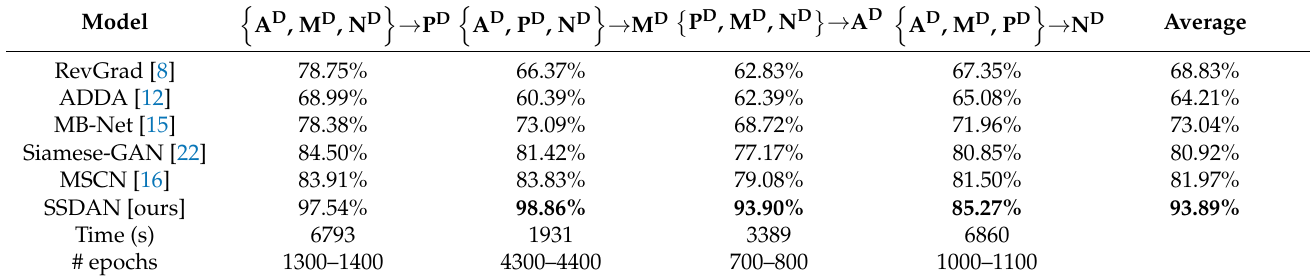
(cid:9) → N D loss, ( d ) Table 5. OA results for the three-source scenarios and comparison to state-of-the-art methods.